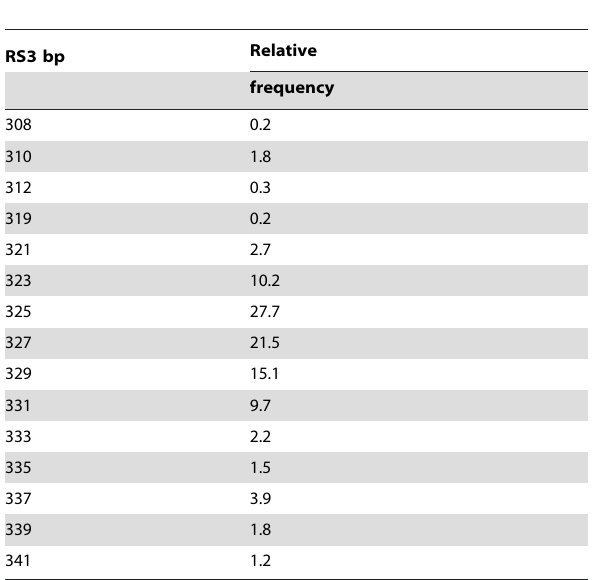
Table 1. Frequencies of AVPR1A RS3 Promoter Region Repeat Alleles, in a Sample of 136 Twins and 162 Parents.